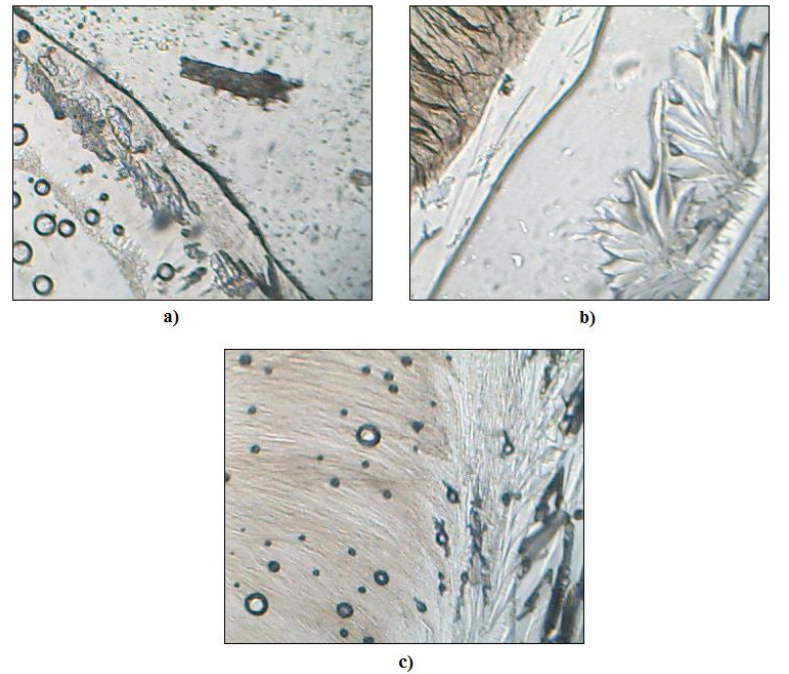
Figure 4. Microstructure of a) tartaric acid; b) citric acid and c)